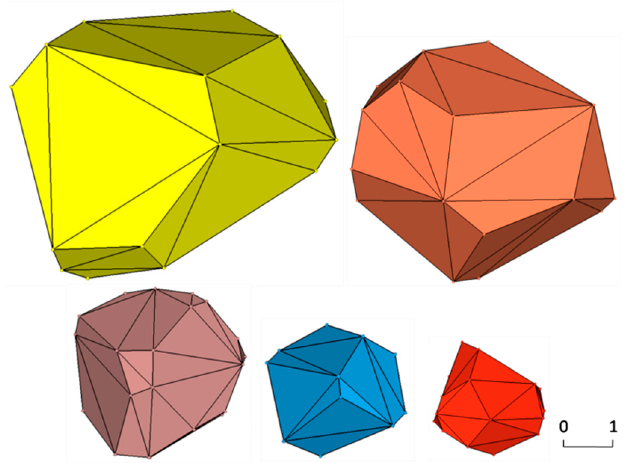
Figure 5. Regeneration aggregate cell with grading